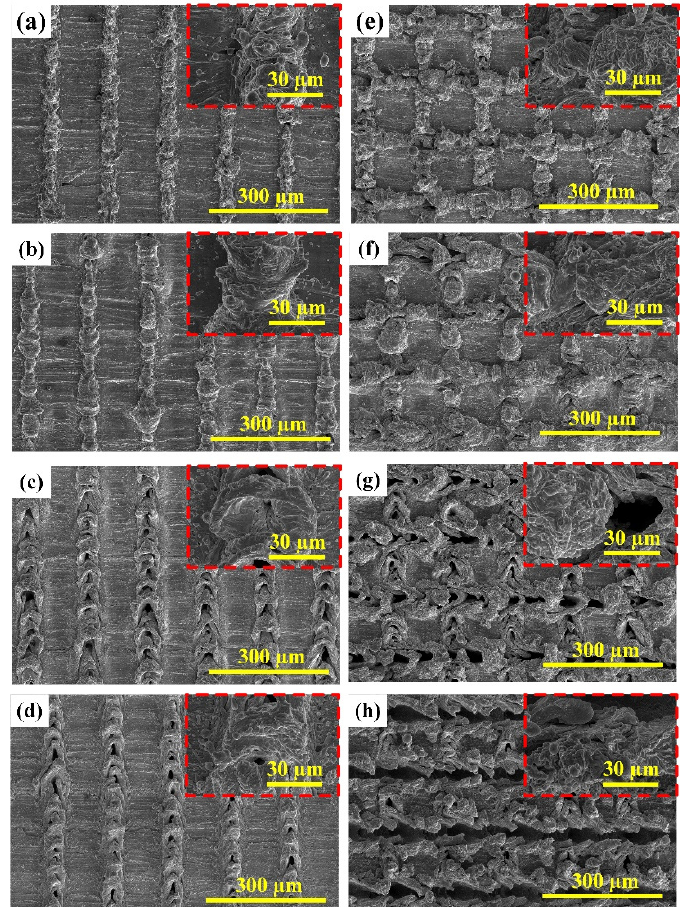
Figure 3. SEM micrographs of the laser textured BMG surfaces using different scanning speeds: ( a – d ) unidirectional surface patterns with the scanning speeds of 20 mm/s, 40 mm/s, 60 mm/s, and 80 mm/s; ( e – h ) cross-hatch surface patterns with the scanning speeds of 20 mm/s, 40 mm/s, 60 mm/s, and 80 mm/s.